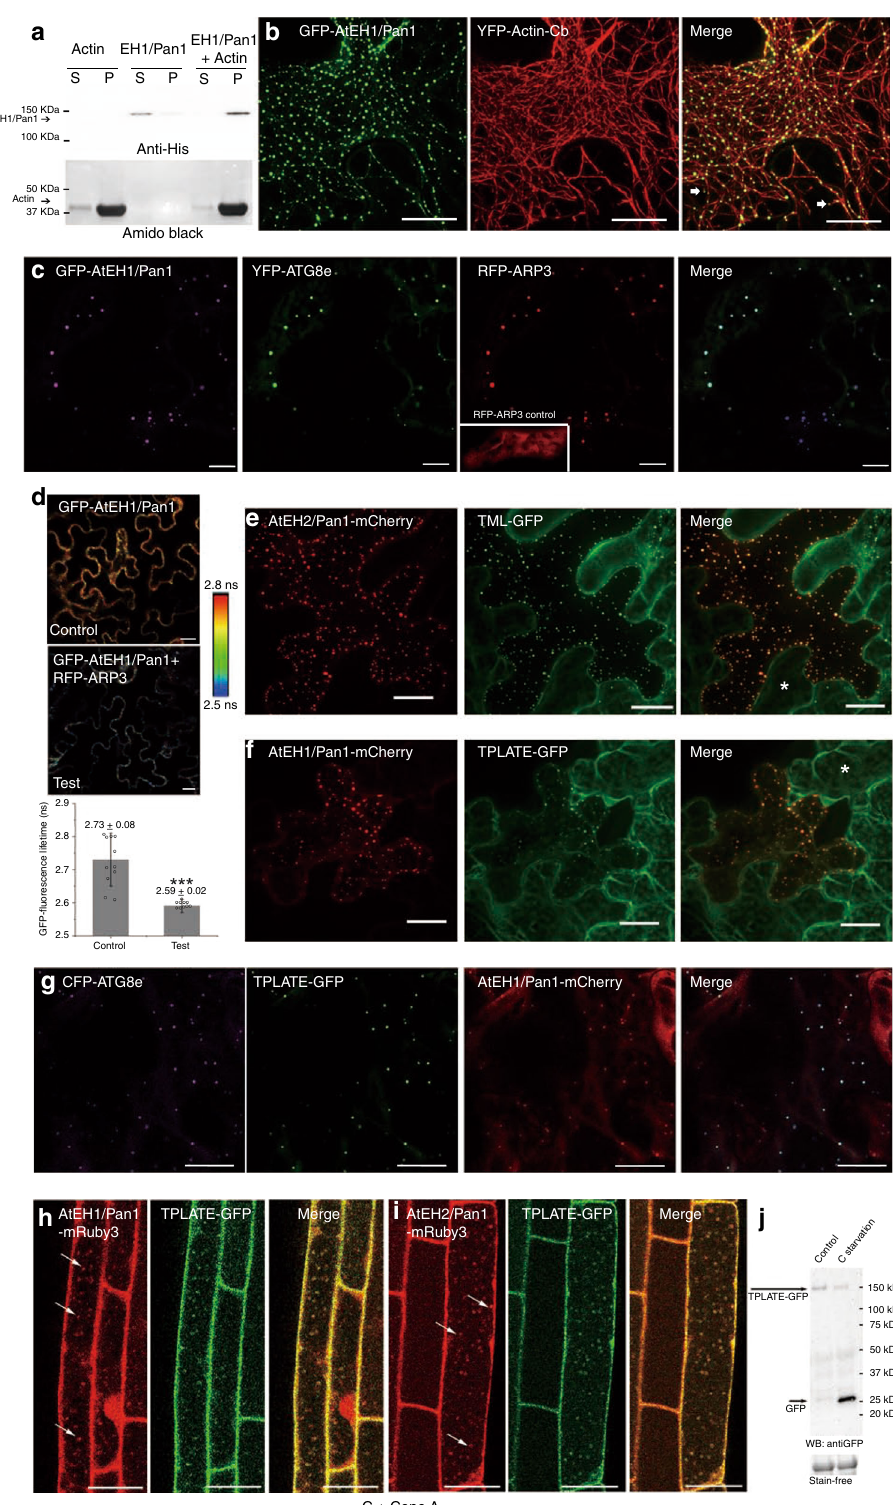
Overexpression of AtEHs/Pan1 promotes autophagy . The number of autophagosomes signi fi cantly increases with the ele- vated expression of AtEH1/Pan1 in N. benthamiana leaf epi- dermal cells. ATG genes are also upregulated compared to the vector-only control (Fig. 6a), suggesting that the expression of GFP-AtEH1/Pan1 boosts autophagic activity in these